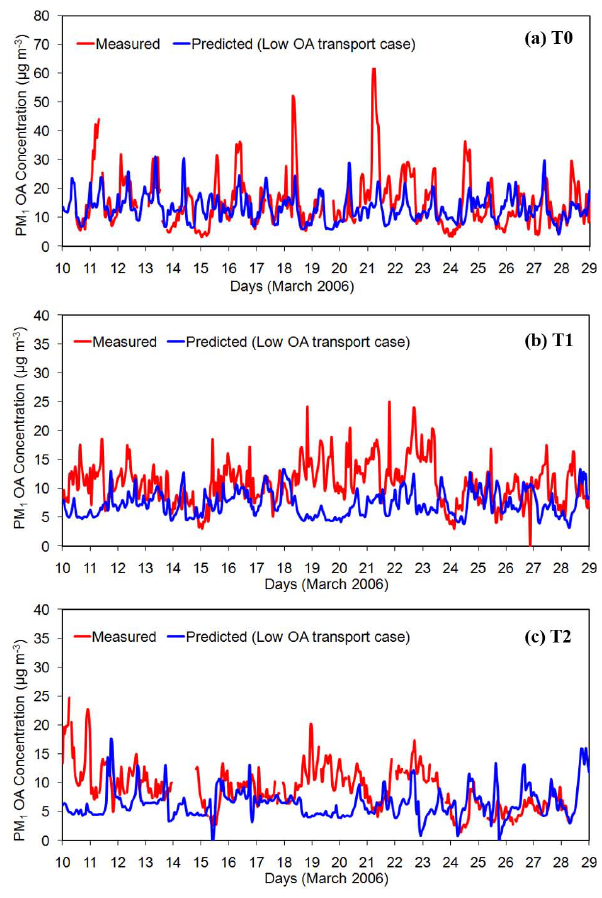
Fig. 14. Comparison of model predictions in the low boundary con- ditions case with hourly measurements for total PM 1 organic mass concentration taken during the MILAGRO campaign in March 2006 at (a) T0 (urban site), (b) T1 (suburban site), and (c) T2 (rural site) on ground